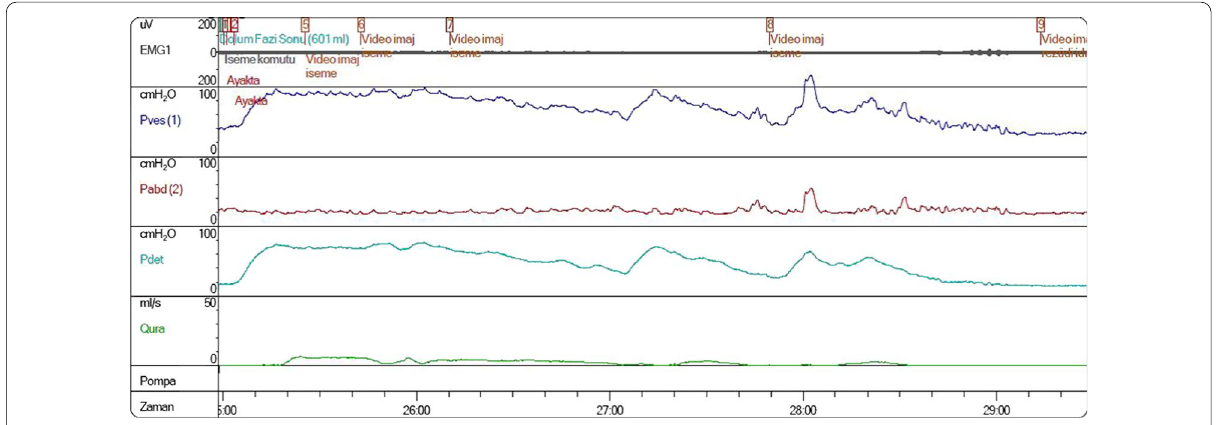
Fig.1 High detrusor pressure and low flow during voiding phase of videourodynamic